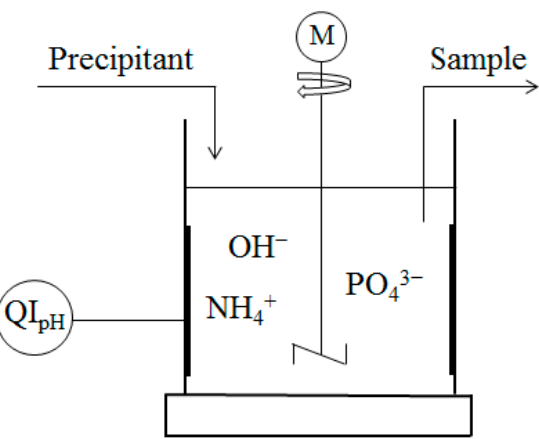
Figure 1. Precipitation reactor consists of a curved blade connected to a motor (M); a 2 L decanter glass with stators attached to the wall of the glass; and a pH-meter (QI pH ).